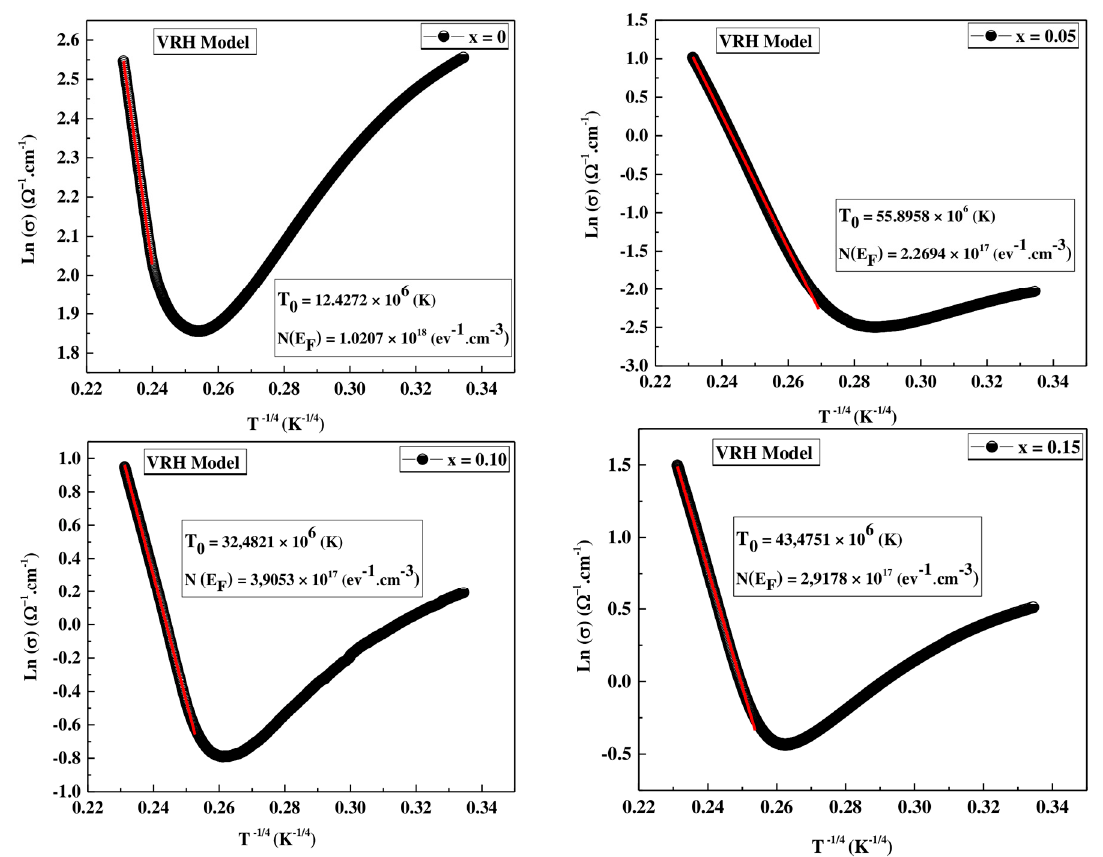
Figure 14. Plots of ln( σ ) vs. T − 1/4 for Pr 0.7 Sr 0.3 Mn ( 1 − x ) Co x O 3 (0 ≤ x ≤ 0.15) compounds. The red solid line corresponds to fit by Equation (10). Table 9. Values of activation energy Ea, correlation factors R and Mott temperature (T 0 ) for Pr (cid:2868).(cid:2875) Sr (cid:2868).(cid:2871) Mn ((cid:2869)(cid:2879)(cid:2934)) Co (cid:2934) O (cid:2871) (0 ≤ x ≤ 0.15) using VRH (Equation (10)) and ASPH (Equation (12)) models.